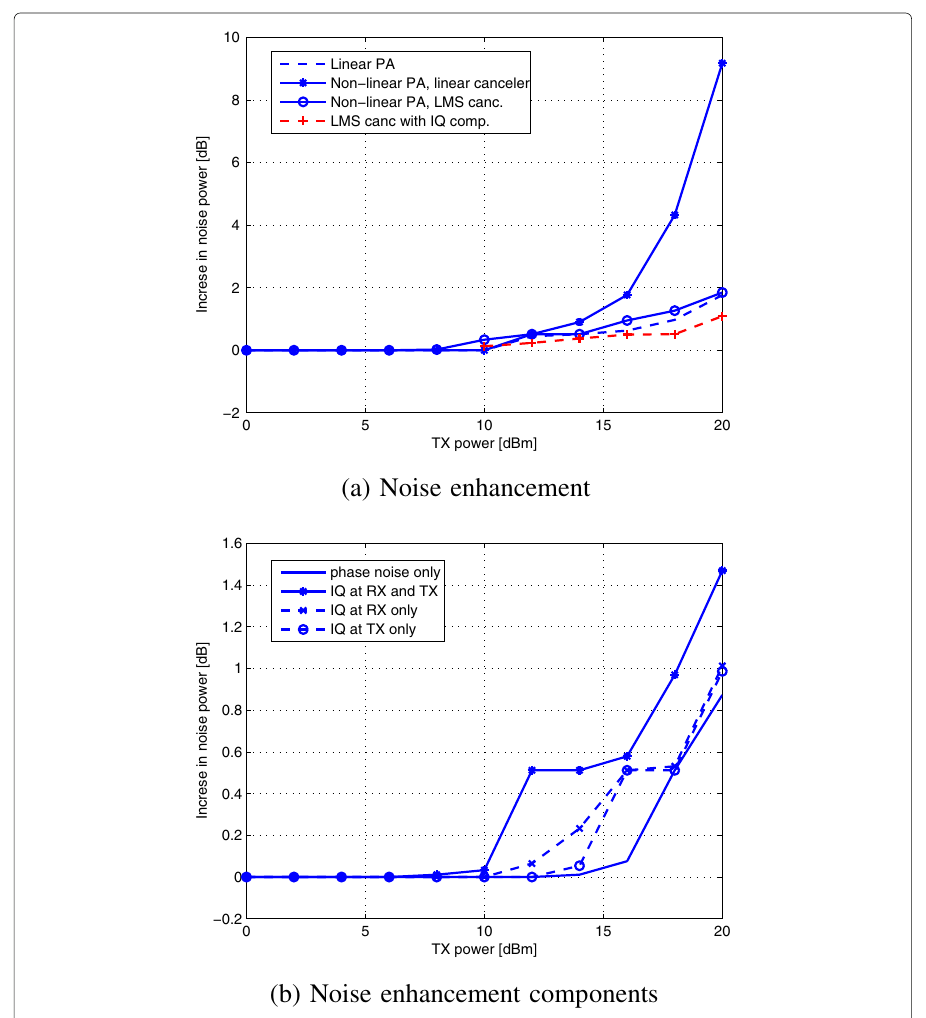
Fig. 7 Increase in noise level after digital SI cancelation. a Total noise enhancement. b Noise enhancement